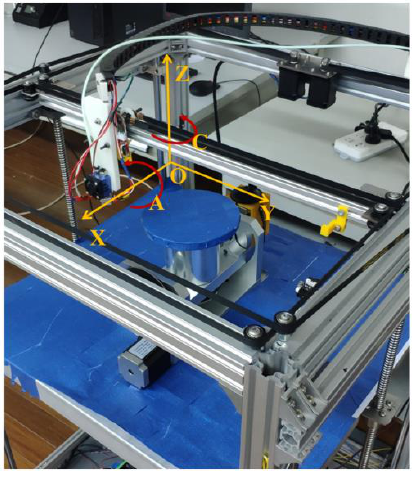
Figure 10. Five-axis printing platform.